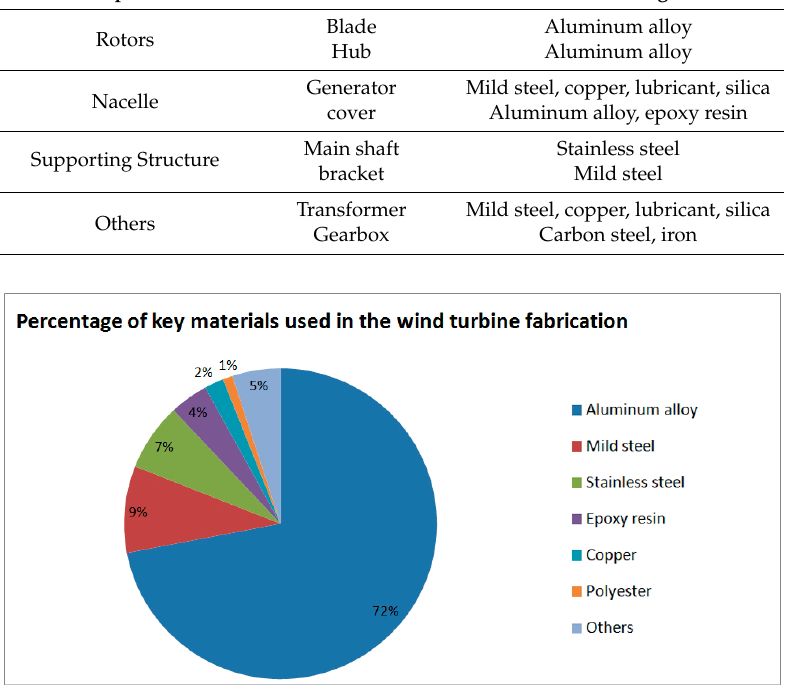
Figure 15. Percentage of key materials used in the wind turbine fabrication. Reprint with permission from Reference [68]; 2006, SAGE.